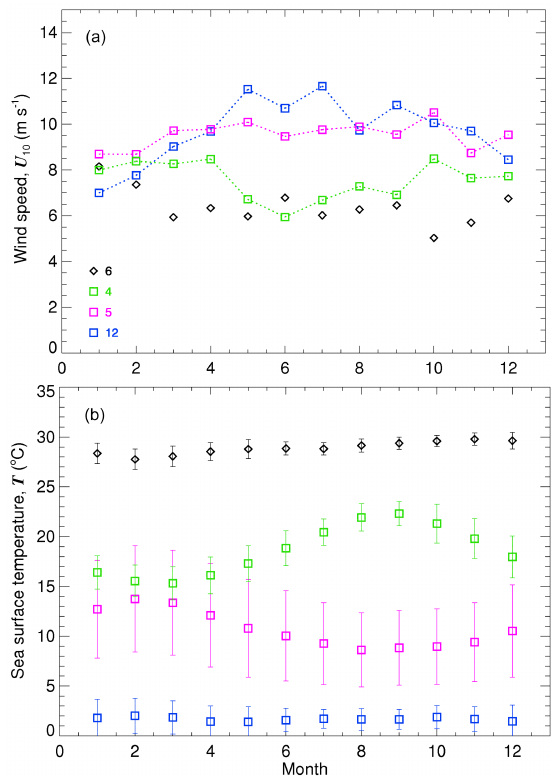
Figure 3. Seasonal cycle for 2006 in different regions as defined in Fig. 2 and Table 1: (a) wind speed U 10 ; (b) sea surface temperature (SST) T . The SST error bars in (b) are ± 1 standard deviation; the U 10 error bars are wider and not plotted in (a) for clarity. The re- gions represent: 4 – temperate zone in the Northern Hemisphere; 5 – temperate zone in Southern Hemisphere; 6 – doldrums along the Equator; 12 – lowest